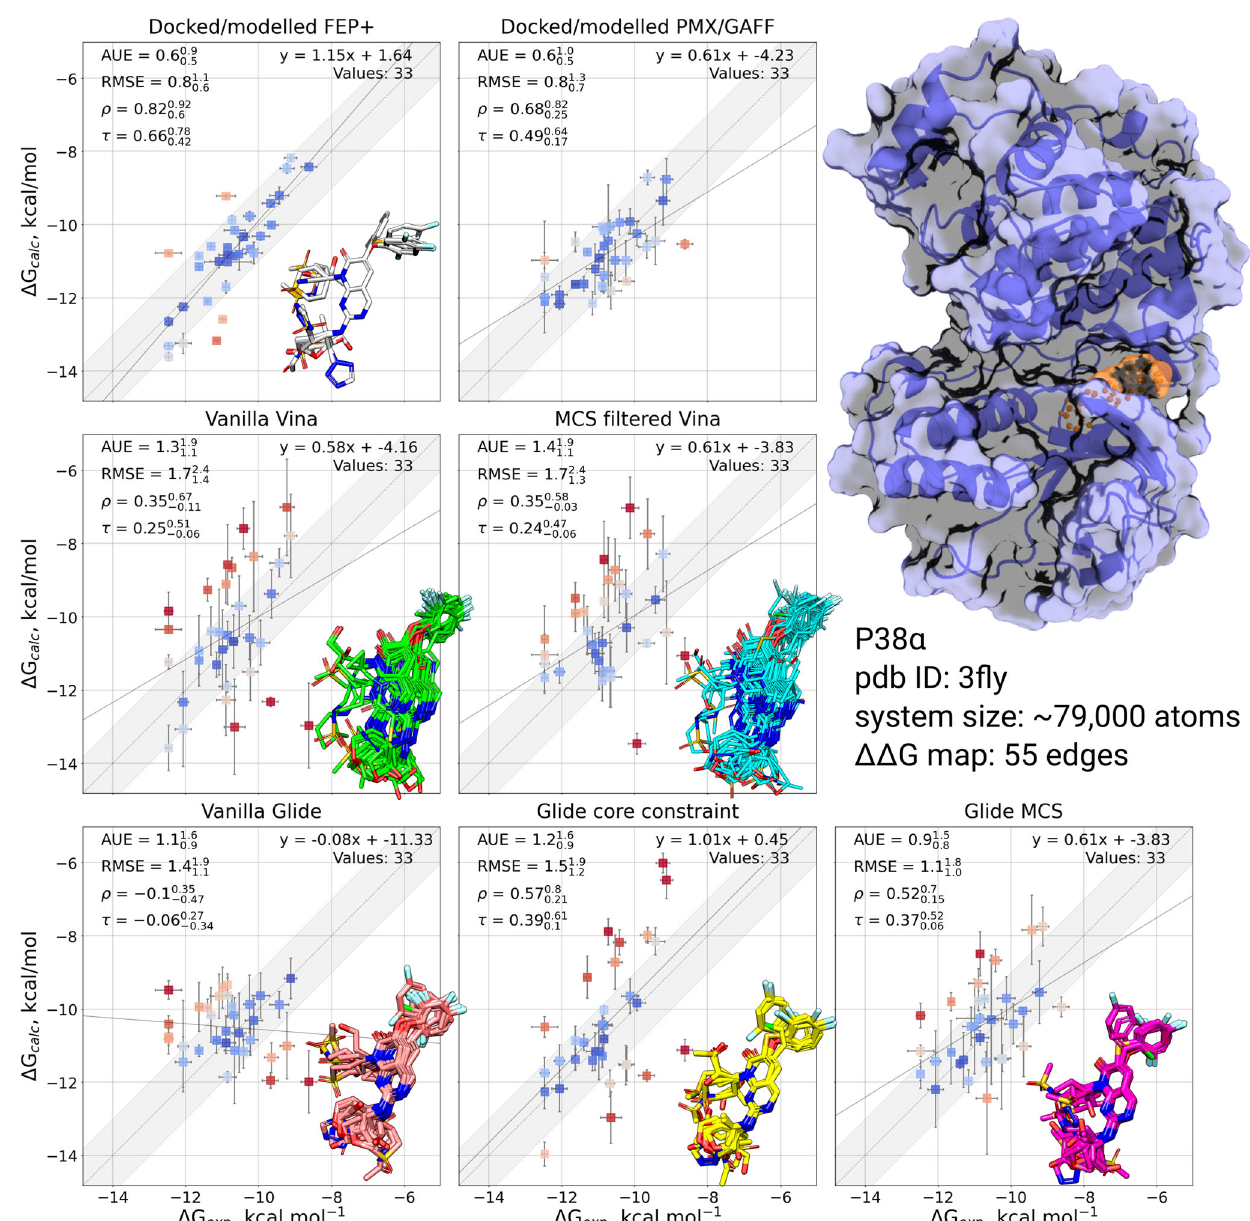
Fig. 1 Comparison of experimentally measured and calculated binding af fi nities for P38 α protein-ligand system. The simulations were initialized with different starting structures (docked/modelled or docked only). The data in the panel Docked/modelled FEP + and Docked/modelled PMX/GAFF are from Gapsys et al. 3 . Overlays of starting ligand poses are inset into the corresponding plot. Experimental errors are taken from the original publication, whilst prediction errors correspond to the standard error over 3 simulation replicas also taking into account the bootstrapped uncertainty of individual free energy estimates. The shaded grey region corresponds to a 1 kcal mol − 1 deviation from experiment, and the solid line is a linear fi t through the data. The crystal structure with a bound ligand highlighted in orange is shown in the top fl uoride ring is responsible for the larger errors observed in the RBFE correlations. All automated protocols are outperformed by the manually modelled poses (AUE and RMSE ranged between 0.9-1.4 kcal mol − 1 and 1.1-1.7 kcal mol − 1 c.f. 0.6 kcal mol − 1 and 0.8 kcal mol − 1 respectively for modelled poses), illustrating the